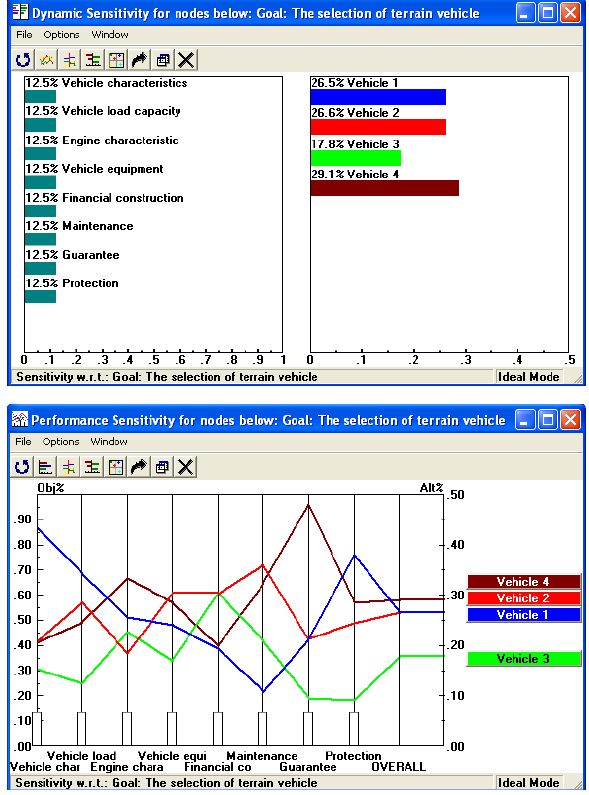
Figure 15. All the criteria and sub-criteria of the same